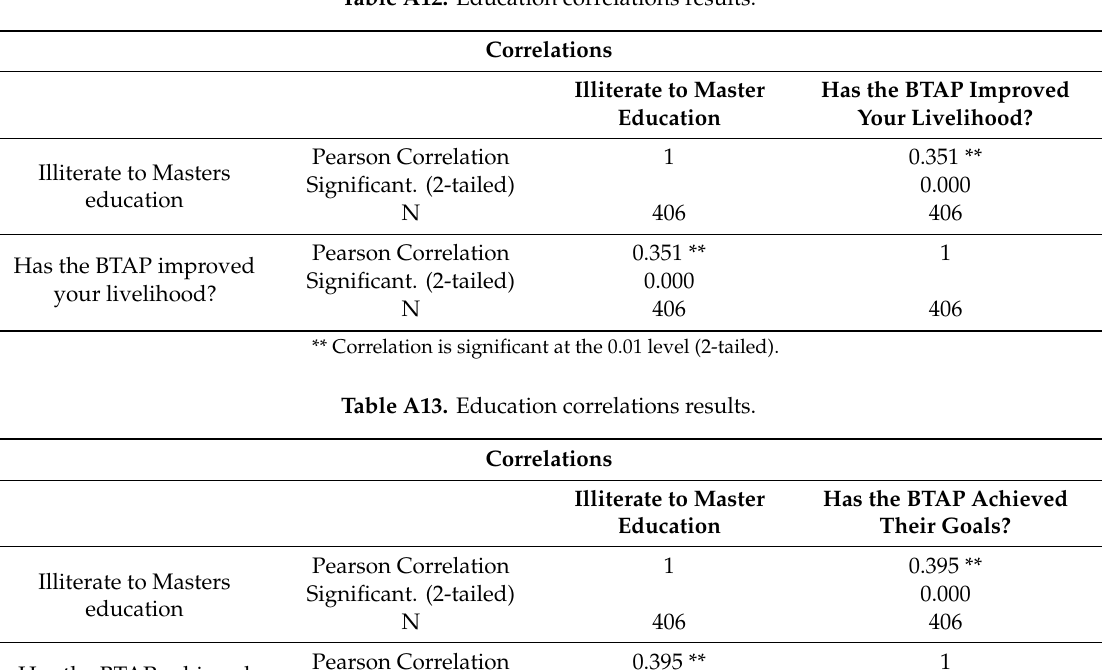
Table A12. Education correlations results.